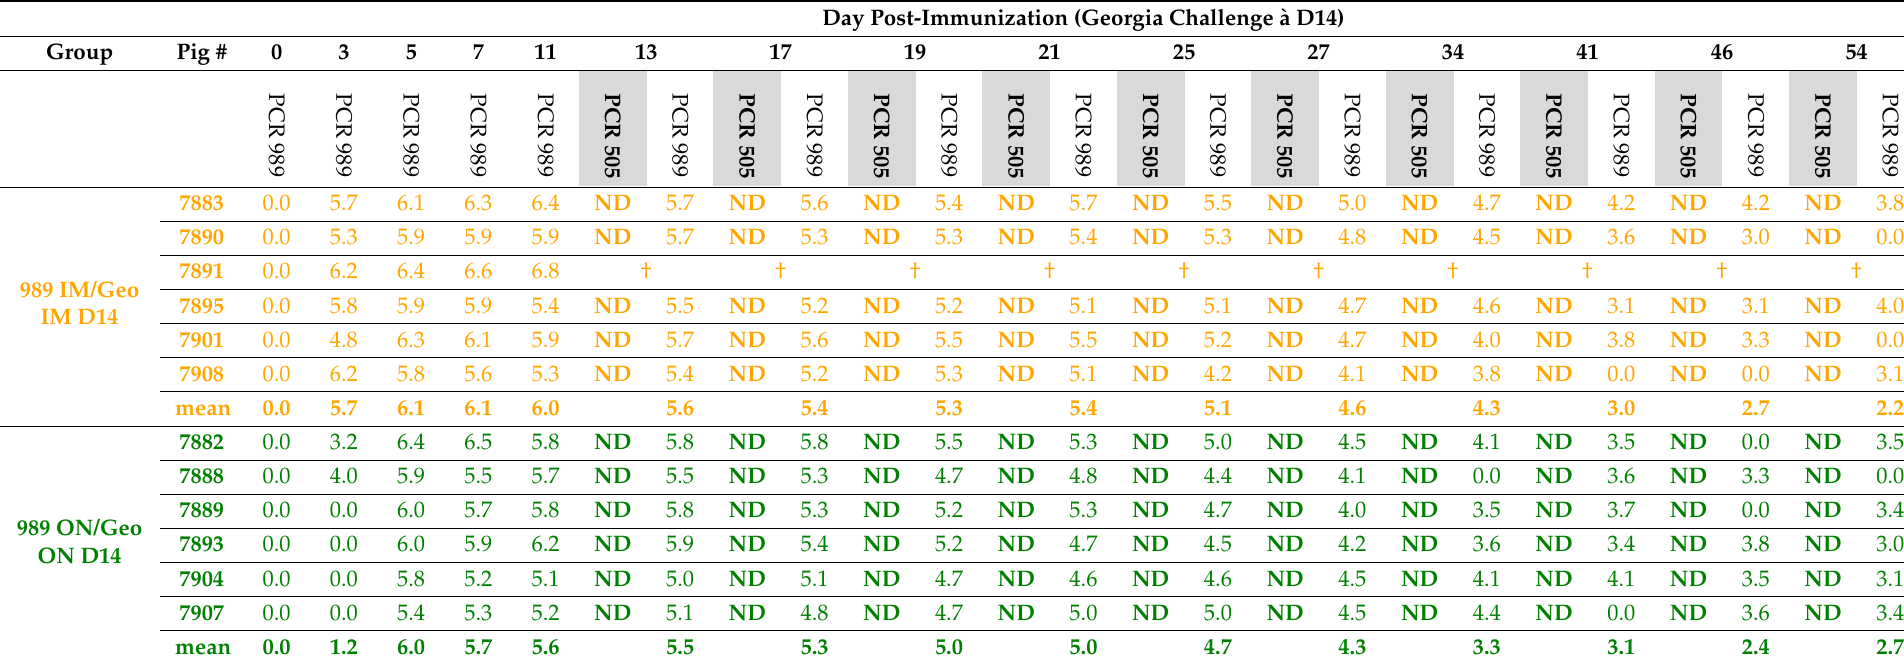
Table 5. Detection of ASFV-989 and Georgia viremia in immunized pigs challenged with Georgia strain 14 days after